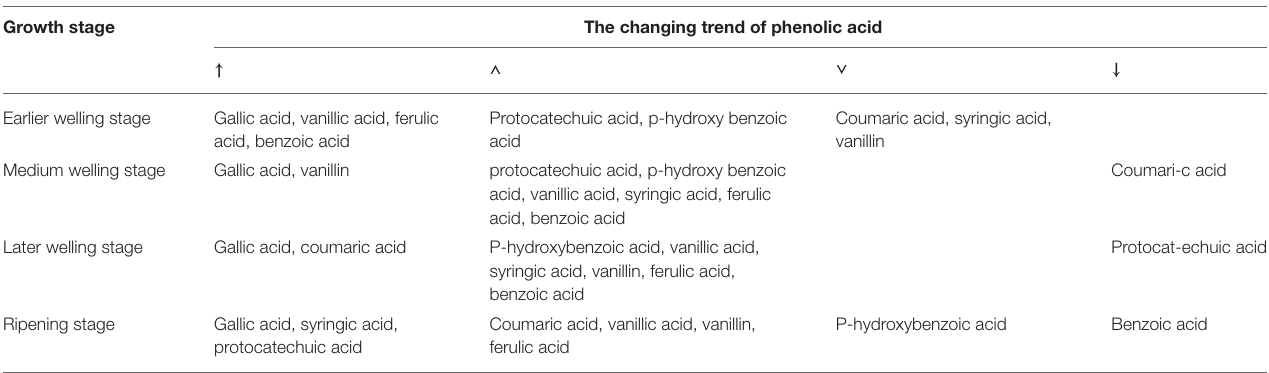
TABLE 2 | The dynamic changes of phenolic acids in the rhizosphere soil of R. pseudostellariae at different growth stages in a continuous cropping system. Growth